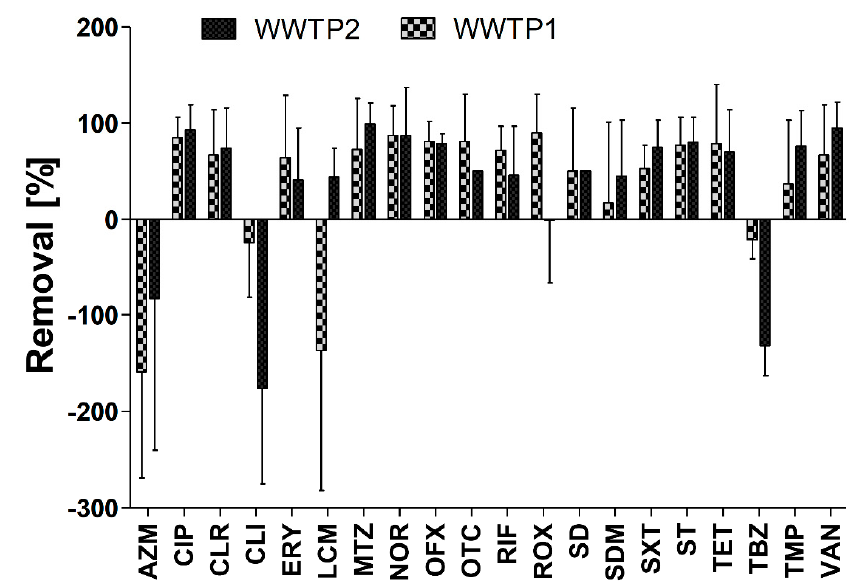
Figure 2. Removal e ffi ciency (%) of selected antimicrobials in WWTPs calculated based on equations Figure 2. Removal efficiency (%) of selected antimicrobials in WWTPs calculated based on equations described in Section described in Section 3.3.